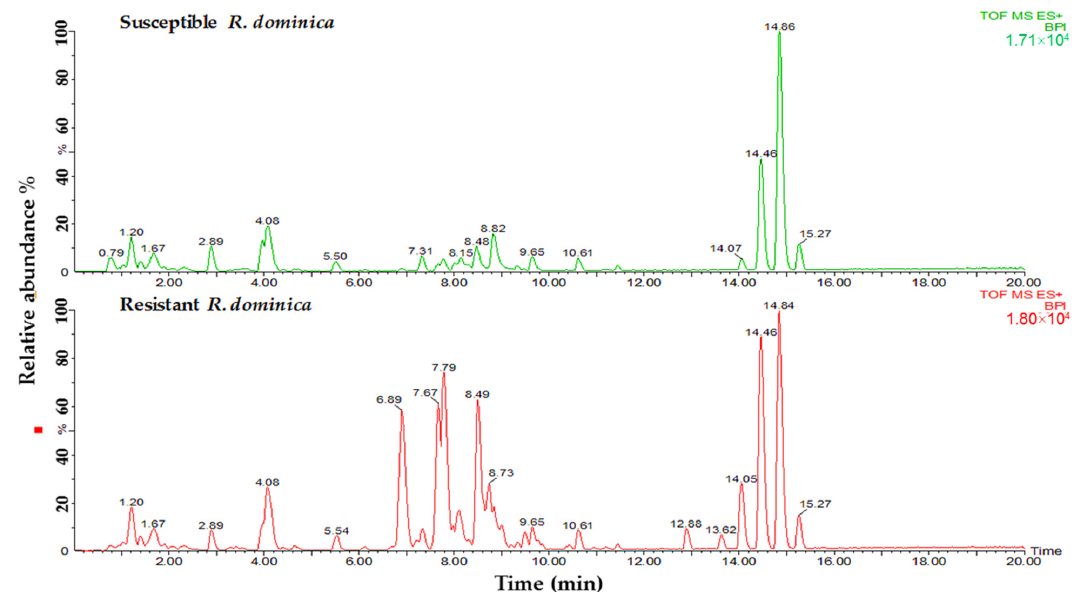
Figure 3. Base peak intensity (BPI) chromatograms show the differences in the lipid content obtained from susceptible (green) and resistant (red) strains of R. dominica. from susceptible (green) and resistant (red) strains of R. dominica